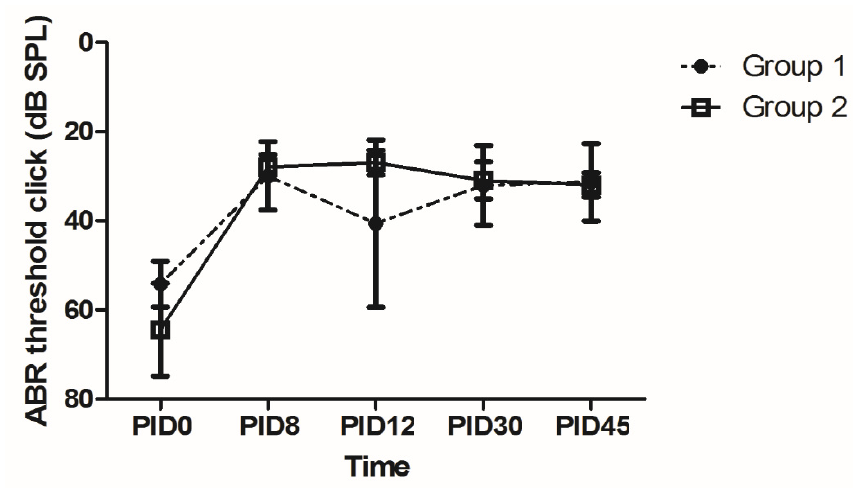
Figure 4. Audiometric assessment based on the auditory brainstem response (ABR). The hearing threshold significantly recovered on PID8. The hearing in both groups was comparably good after 30 to 45 days. The final hearing threshold was 31.4 ± 3.3 dB SPL and 32 ± 1.2 dB SPL in groups 1 and 2, respectively.